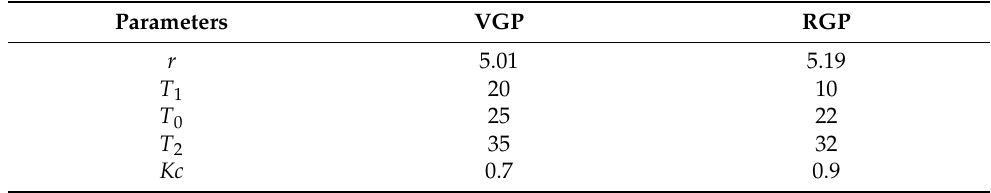
Table 1. Values of related parameters for calculating the suitability of sunshine, temperature, and precipitation in vegetative growth period (VGP) and reproductive growth period (RGP) of summer maize.